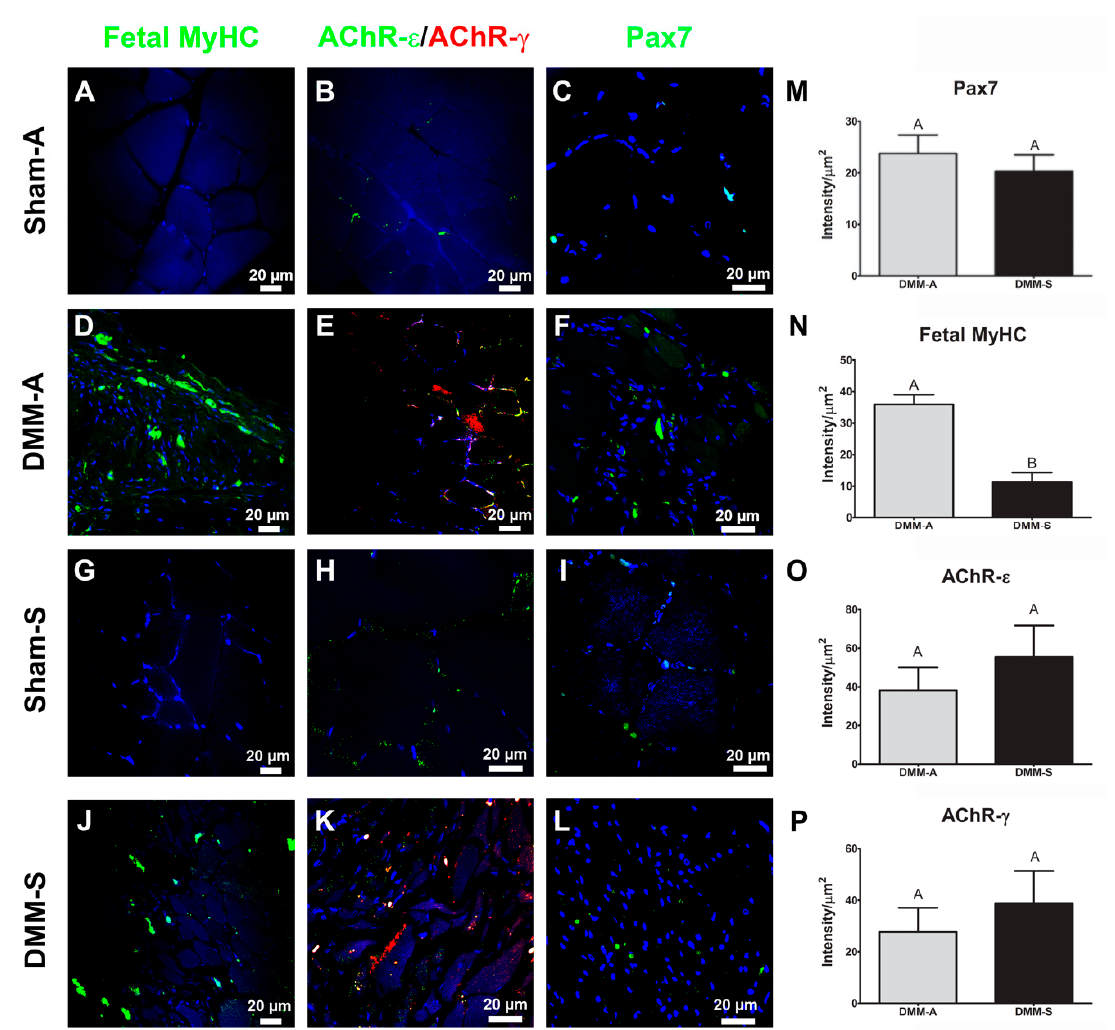
Figure 4. DMM supports satellite cells, de novo muscle fibers, and neuromuscular receptors in both Sprague Dawley and RNU rats. Immunostaining for fetal myosin heavy chain (fMyHC) ( A , D , G , J ), nicotinic acetylcholine receptor (AChR) - ε and - γ ( B , E , H , K ), and Pax7 ( C , F , I , L ) was quantified. Pax7 staining was similar ( M ), fetal MyHC was increased in RNU rats compared to Sprague Dawley ( N ), AChR- ε was unchanged ( O ), and AChR- γ was unchanged ( P ). Representative stained sections for RNU ( E ) and Sprague Dawley ( F ) rats are shown. Data shown are representative images from 8 animals and are means ± SEM of 8 animals. Letters not shared indicated a significant difference ( p < 0.05, Tukey).